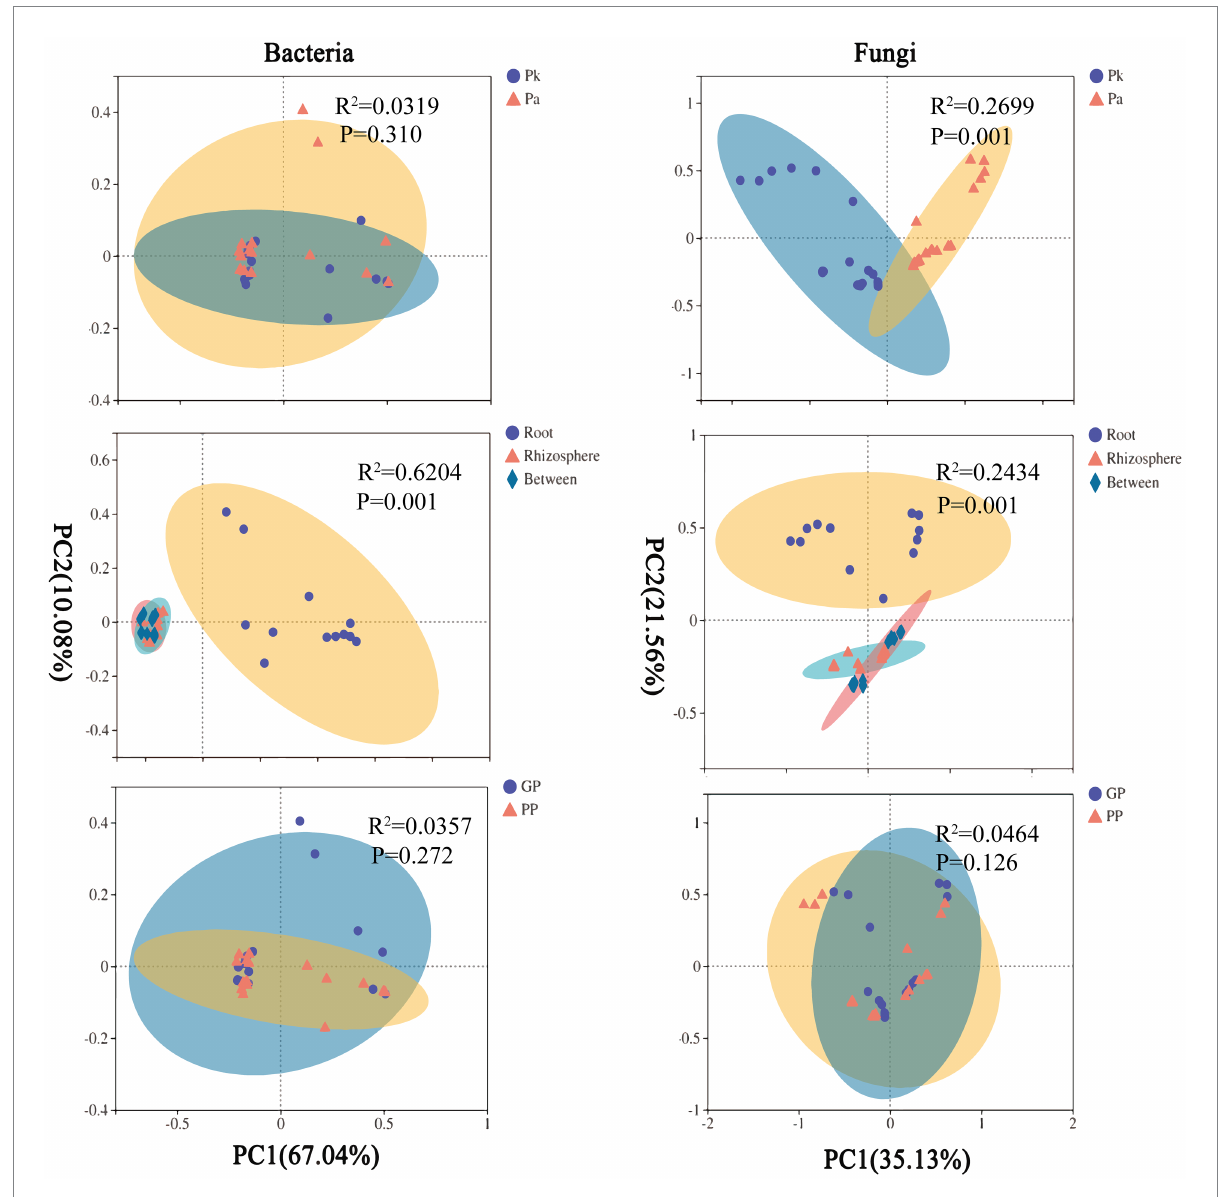
FIGURE 7 Principal co-ordinates analysis (PCoA) plots based on the weighted UniFrac distance (WUF) of pine-asscioated microbes. Pk, samples of Pinus kesiya var. Langbianensis, Pa , samples of Pinus armandii Franch., GP, P.n. -pine agroforestry systems, PP, pure pine